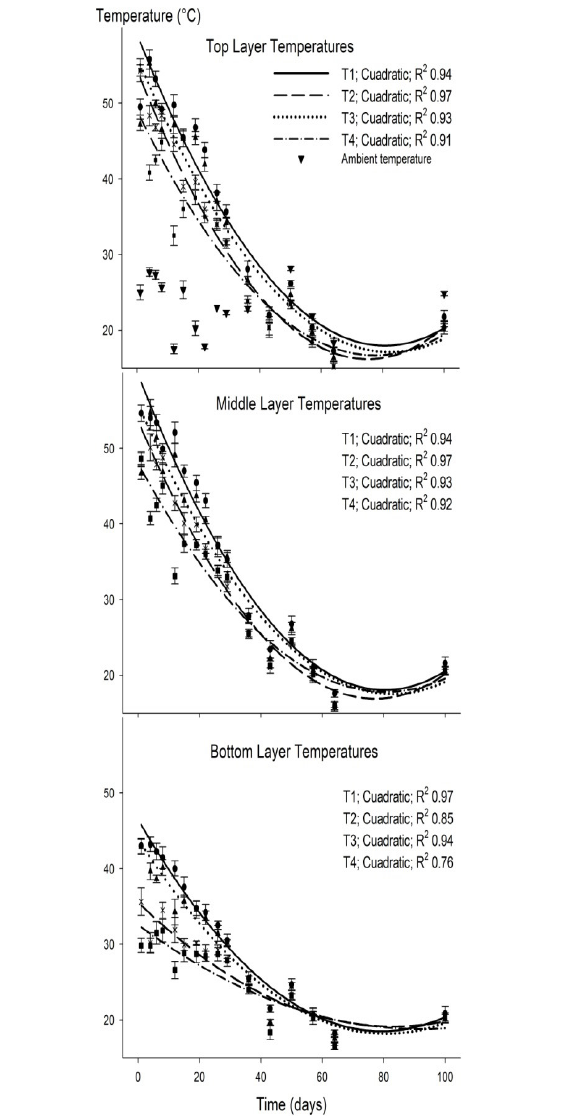
Figure 1: Mean temperature of static piles (T1 ● prickly pear cactus+BP; T2 ᵡ moringa+BP; T3 ▲ prickly pear cactus; T4 ▀ moringa) per layer over the most active phases (100 days). Means (±SD) were calculated from five replicates for each treatment and sampling day. Statistically different (Tukey test,